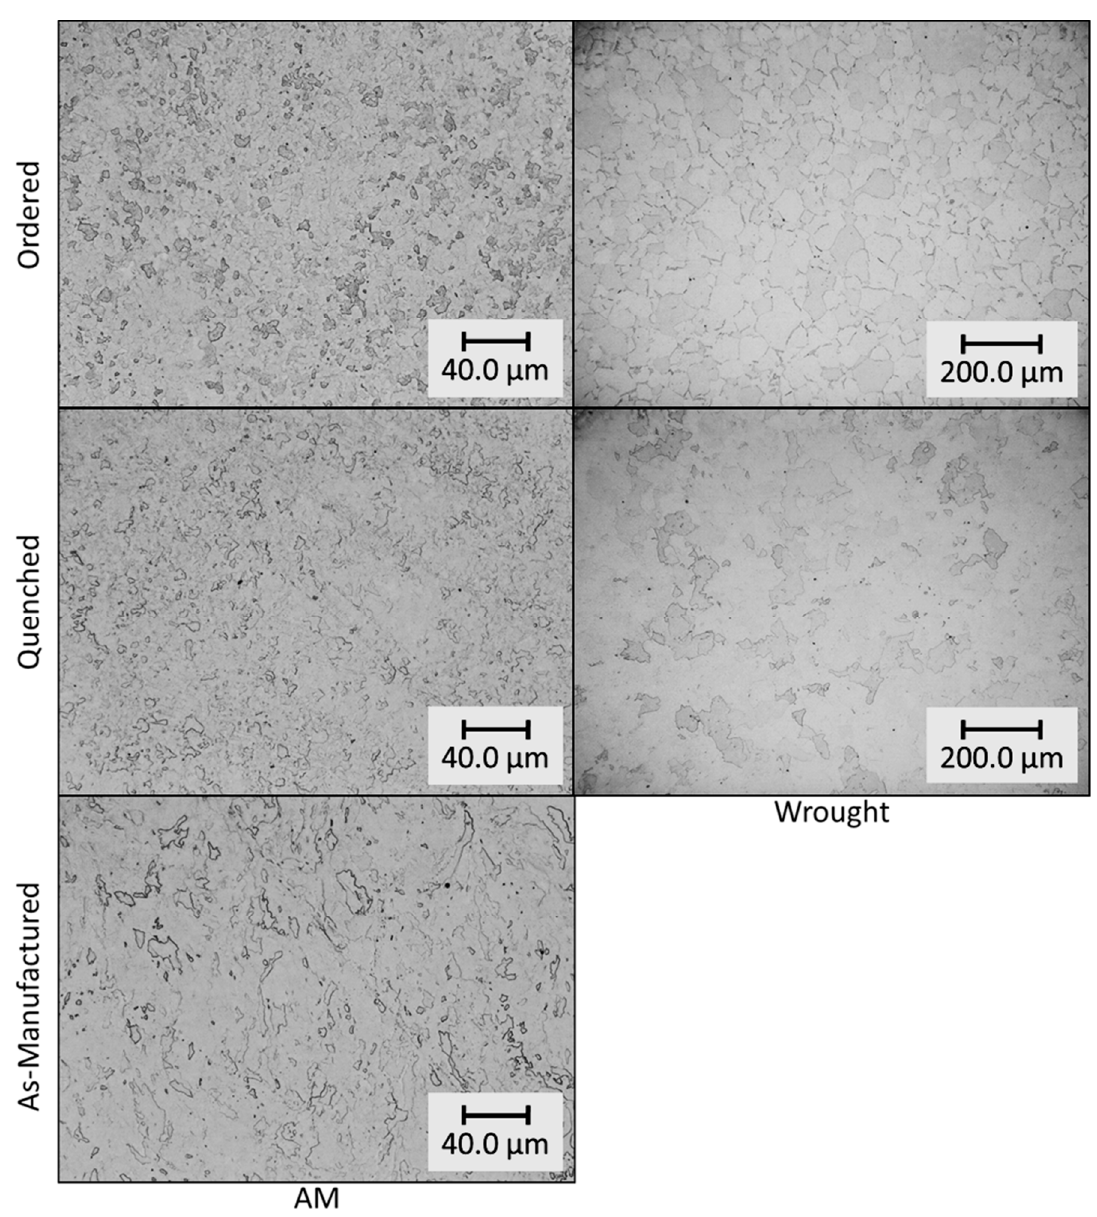
Figure 2. Characteristic microstructures of AM and wrought material in various heat treatment conditions. AM images are on the left and wrought images are on the right. Samples were etched with Ralph’s reagent. Table 2. Nominal composition of Hiperco 50A and measured chemistry with test precision for wrought and AM material.